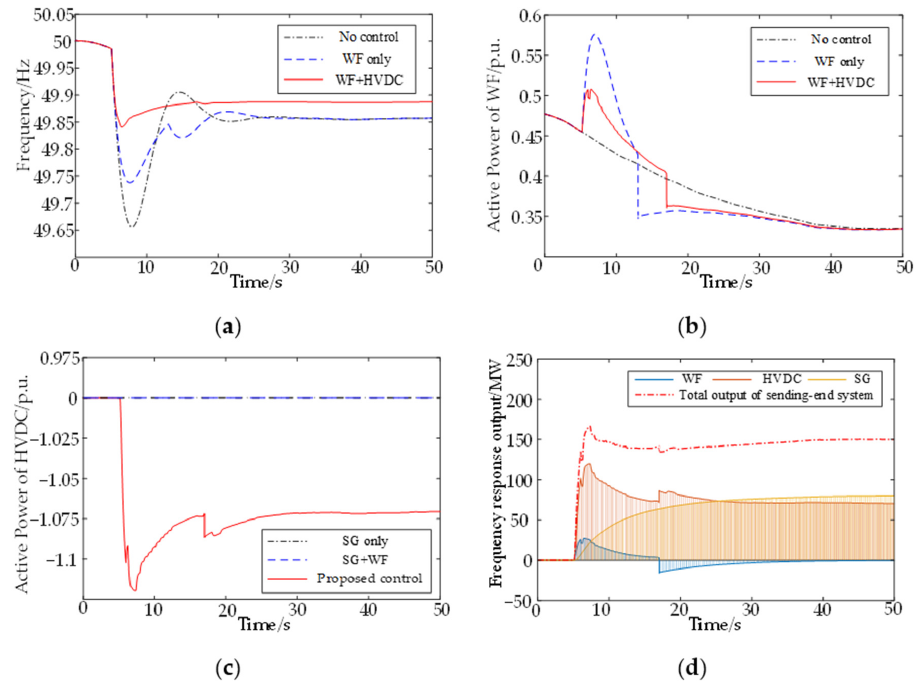
Figure 18. Simulation results under middle wind power permeability and variable wind speed condition. ( a ) Sending-end system frequency, ( b ) active power of WF, and ( c ) active power of HVDC, ( d ) frequency response output of sending-end